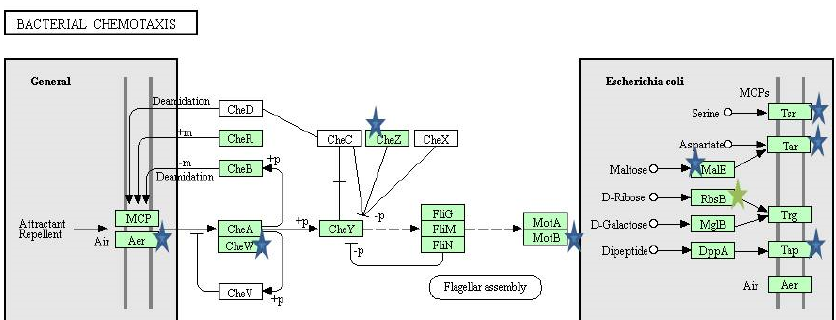
Figure 9. Flagellar pathway assembly (KEGG database). Blue stars represent the downregulated genes in bile and bile antibiotic treatment, green stars represent the genes downregulated in only bile treatment. Red stars represent the upregulated genes (B vs. BAB).